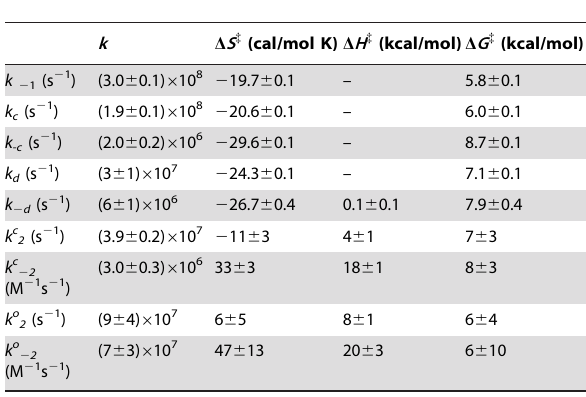
Table 3. Microscopic rate constants, activation enthalpies (kcal mol-1) and entropies (cal mol-1 K-1) determined from the global fit of the ps-ms entire time course (at 1 and 0.1 atm CO) of CO rebinding kinetics to Tf-trHb at 20 u